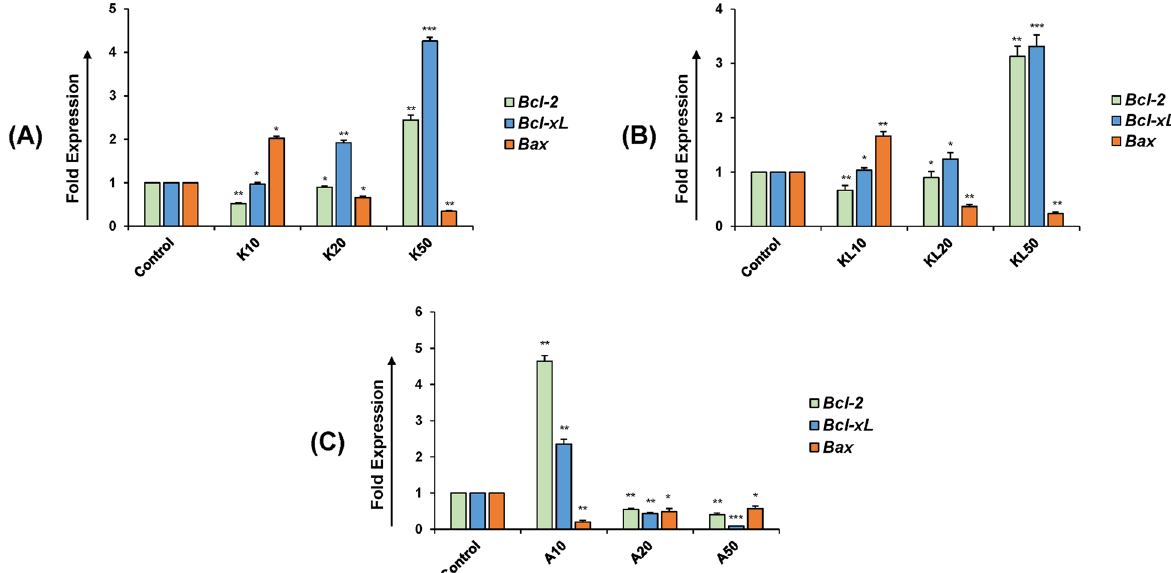
Fig. 2 Bcl-2 , Bcl-xL and BAX genes expression in granulosa cells with KGF and KITLG. A , B A significant increase in Bcl-2 and Bcl-xL expression was observed and Bax was down-regulated in bovine granulosa cells with KGF and KITLG treatment. C Treatment of granulosa cells with combination of KGF and KITLG increased the expression levels of anti-apoptotic proteins ( Bcl-2 and Bcl-xL ) and decreased significantly (** P < 0.01) the pro-apoptotic protein Bax at 10 ng/ml. K represents the KGF, KITLG is denoted by KL and A is KGF KITLG. The dose concentration are defined as 10, 20, and 50 + ng/ml for both KGF and KITLG. Values are expressed as the mean SD of three experiments; * P < 0.05, ** P < 0.01, *** P < 0.001 vs. the control ±